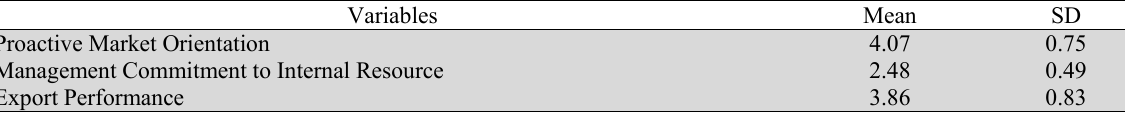
Description of variables Variables Mean SD Proactive Market Orientation Management Commitment to Internal Resource